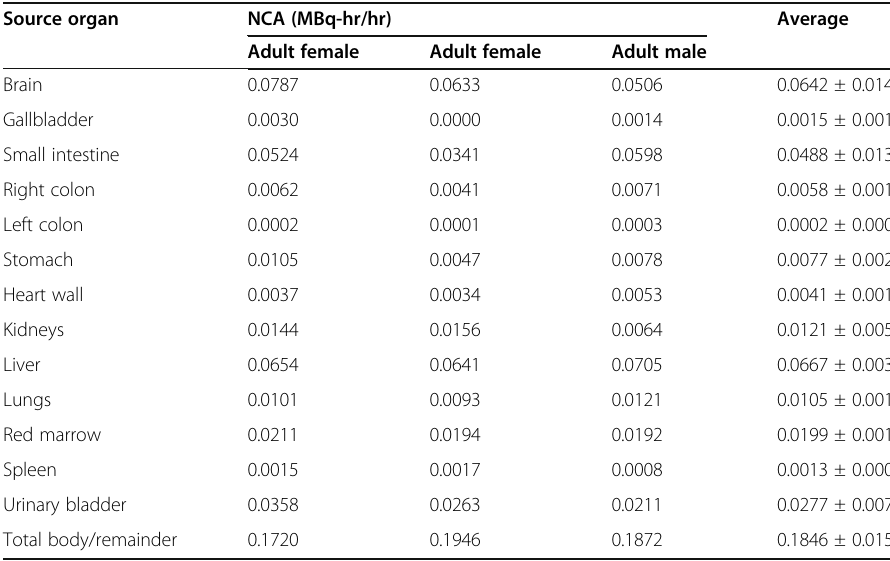
Table 2 Normalized cumulated activity coefficients (NCAs) for indicated source organs determined from whole-body imaging of three healthy subjects injected intravenously with [ 11 C]-UCB-J Source